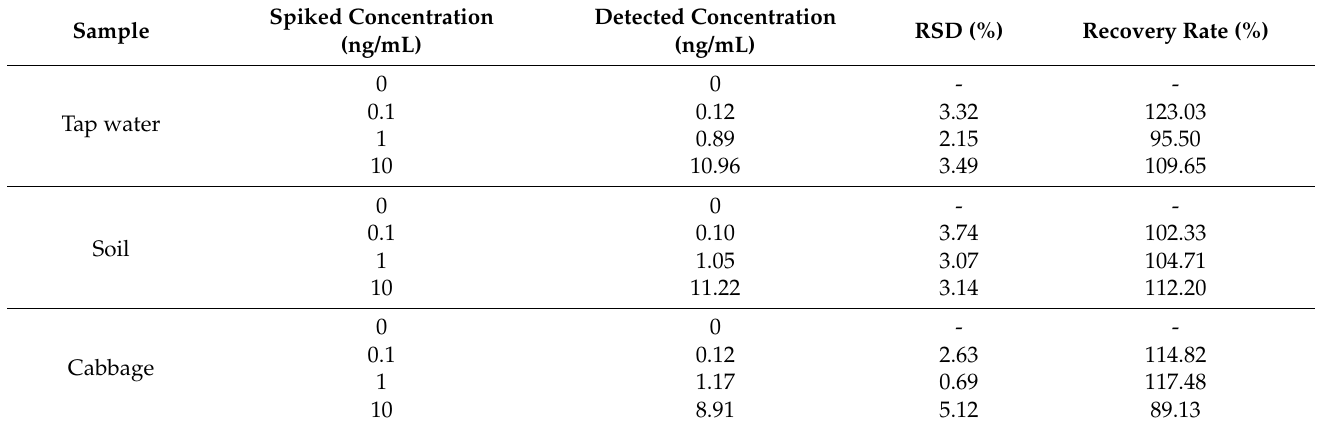
Table 2. Detection results of actual samples (n =